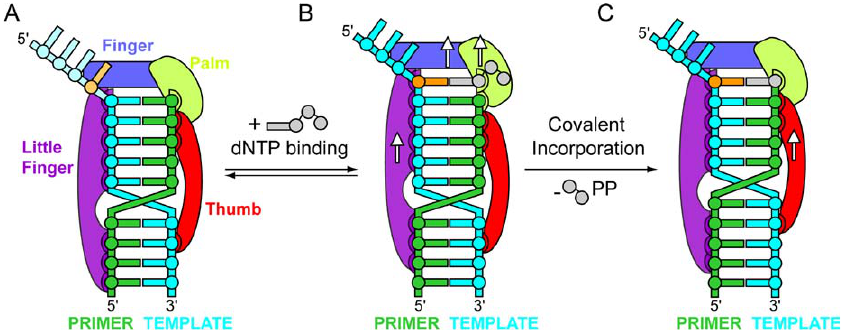
Figure 11. Schematic of Translocation Mechanism of Dpo4 Complexes with oxoG-Modified Template-Primer DNA (A) oxoG-modified preinsertion binary complex, where the overhang segment of the template strand, including oxoG, is disordered in the crystal (shown by light coloration). (B) oxoG-modified insertion ternary complex with incoming dNTP. (C) oxoG-modified postinsertion complex following covalent nucleotide incorporation. The arrows represent one nucleotide translocation of individual color-coded domains in the 3 9 -to-5 9 direction of the template strand. Color-coding. DNA: template strand, cyan; primer strand, green; dCTP, light gray; oxoG residue, orange. Dpo4 domains: palm, light green; finger, blue; thumb, red; little-finger, purple; tether-connecting-thumb and little-finger, gray; Ca 2 þ cations, pink spheres. DOI: